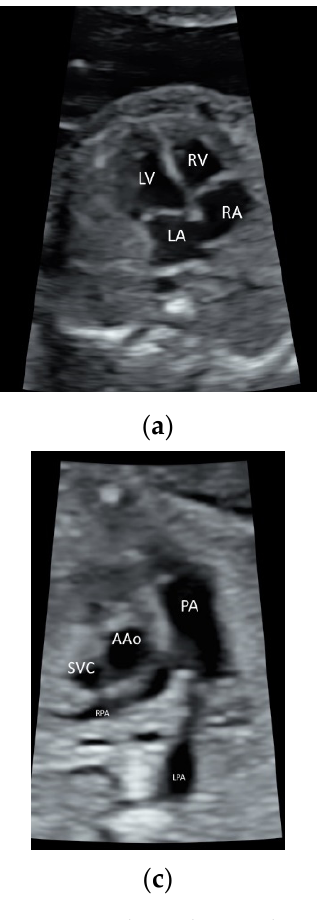
Figure 1. High-resolution ultrasonography of the fetal heart at 20 weeks’ gestation showing ( a ) a four-chamber view showing right atrium (RA), left atrium (LA), right ventricle (RV), and left ventricle (LV), ( b ) five-chamber view showing ascending aorta (AAo) arising from the left ventricle, the right and left superior pulmonary veins (RSPV, LSPV) enter the left atrium (LA), and descending aorta (DAo) behind the LA ( c ) Three-vessel view showing the PA dividing into the left (LPA) and right (RPA) PA, AAo, and the superior vena cava (SVC), ( d ) three-vessel and trachea view showing PA with the ductal branch (DA) joining the DAo, AAo, SVC, and trachea (T); Thymus is anterior to the three vessels.